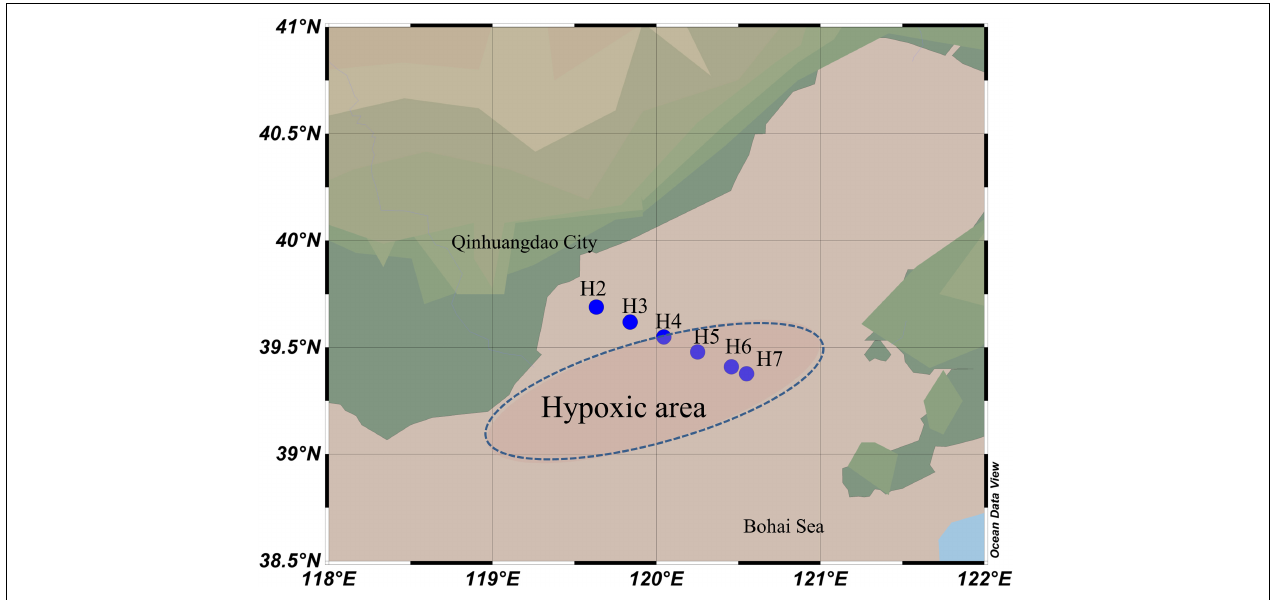
FIGURE 1 | Map showing the sampling sites in Bohai Sea along the inshore–offshore transect. The reported hypoxic area was shown in the blue dash line oval.